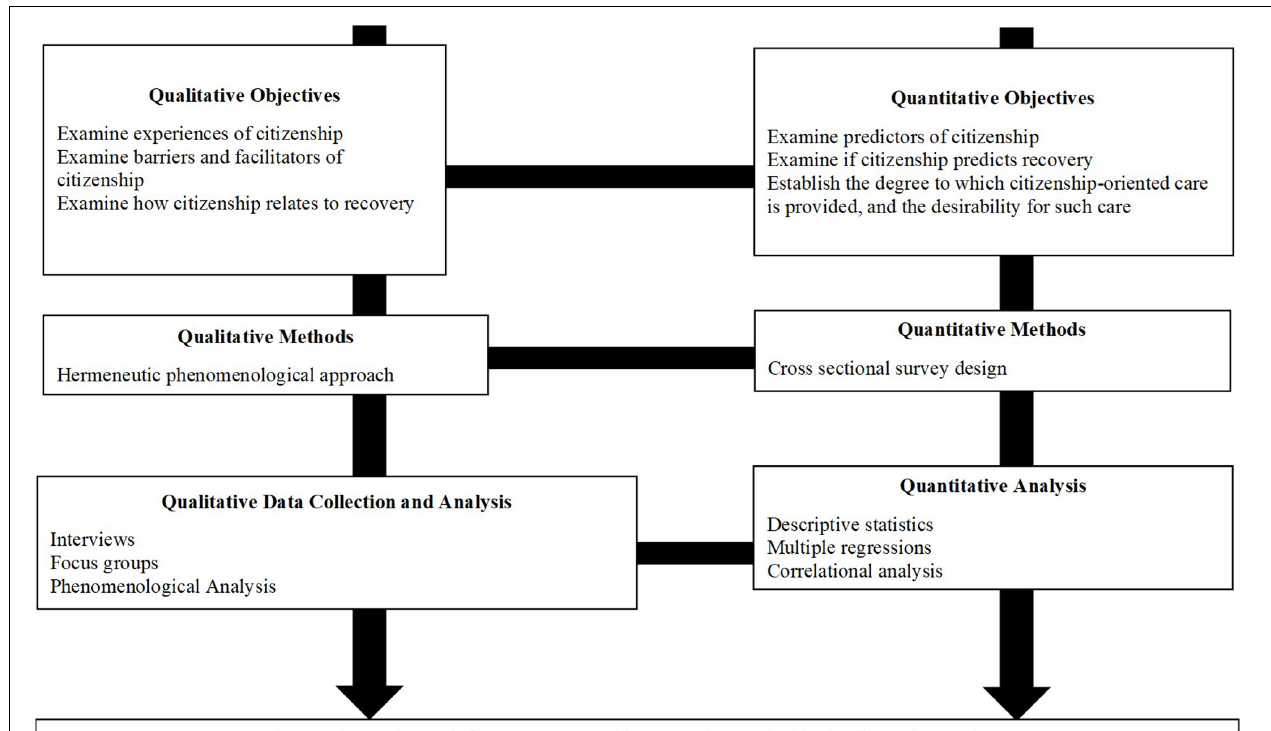
FIGURE 1 | Overall methodological approach for the